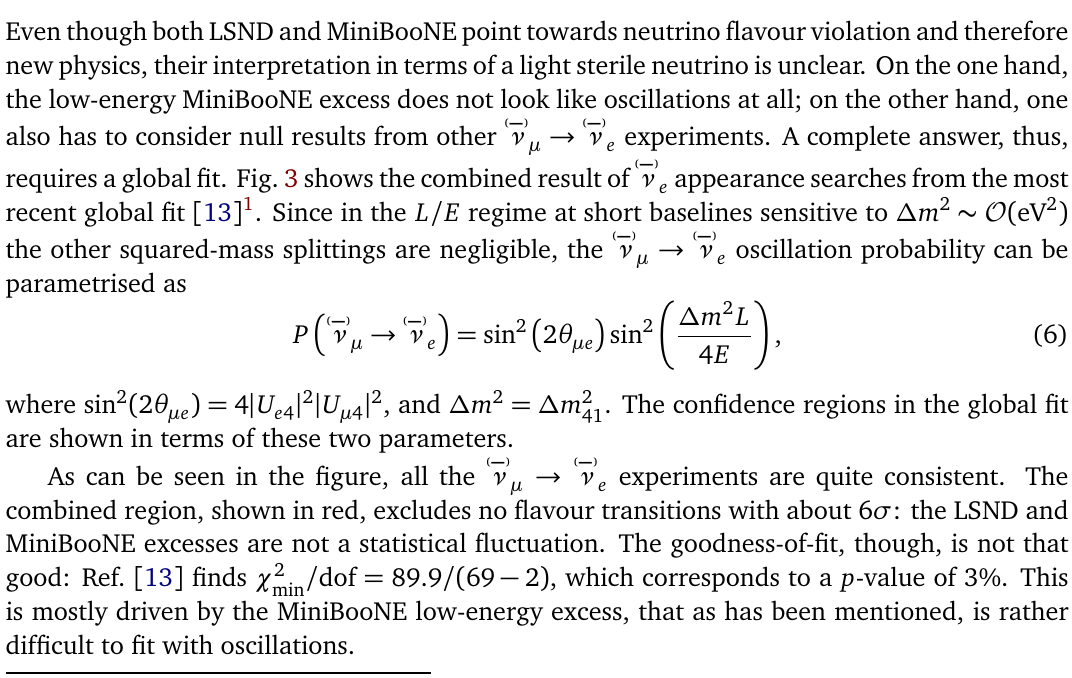
Figure 2: MiniBooNE excess in the ν in solid lines, whereas the best fit assuming oscillations is the dashed line. The region of L / E where LSND saw the excess is located to the right of the vertical blue